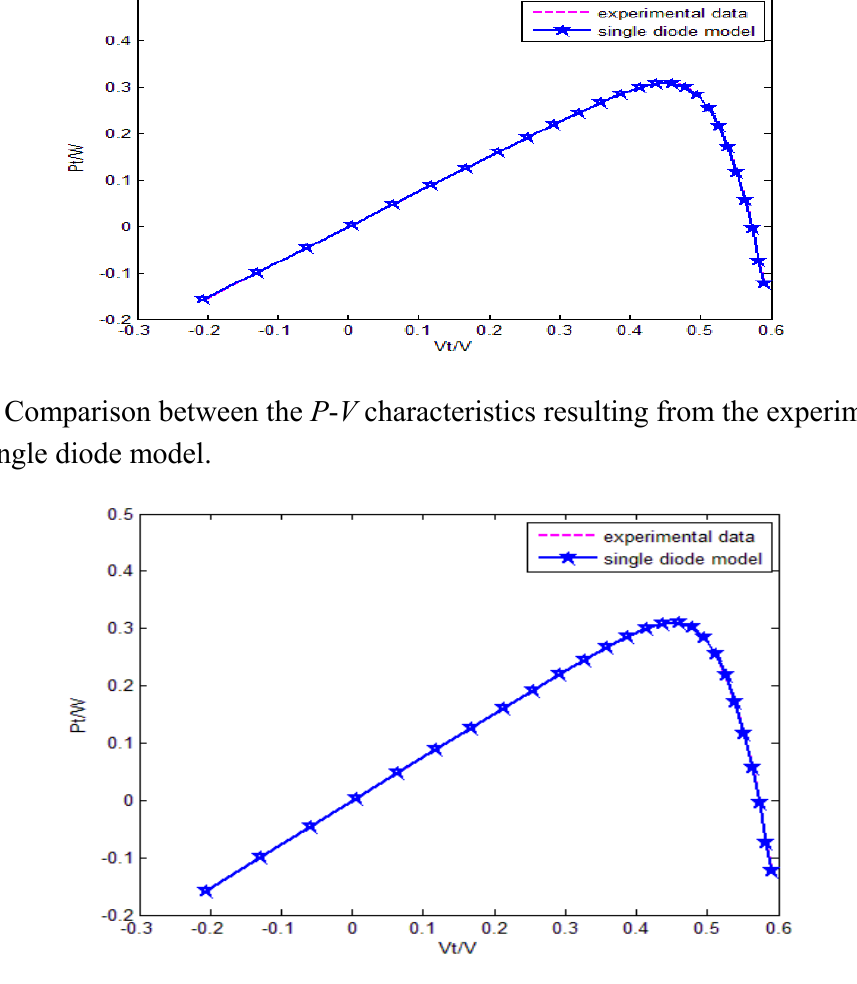
Figure 9. Comparison between the P - V characteristics resulting from the experimental data and the double diode